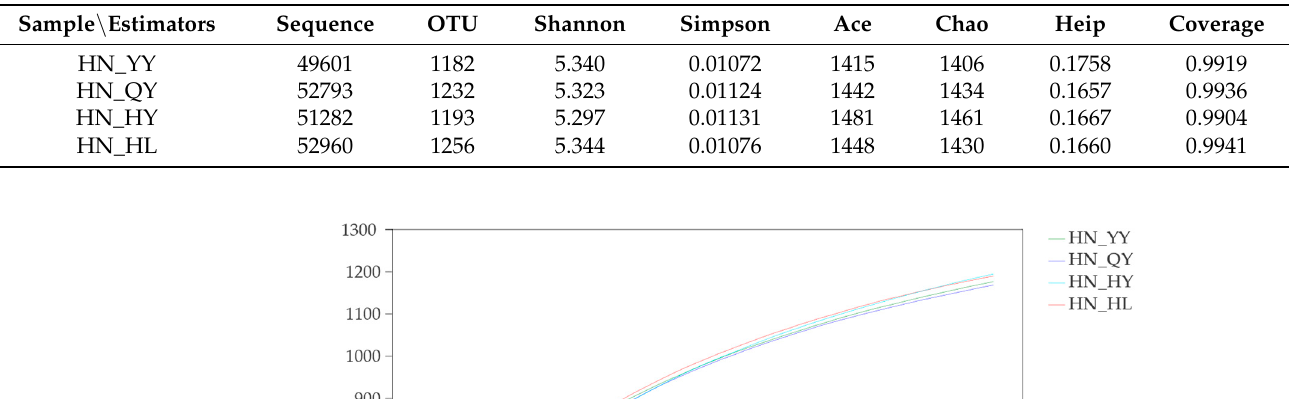
Table 2. Sequence, OTUs, coverage, and Alpha diversity of microbial communities in the anaerobic sludge (HN_YY), anoxic sludge (HN_QY), aerobic sludge (HN_HY), and return sludge (HN_HL).